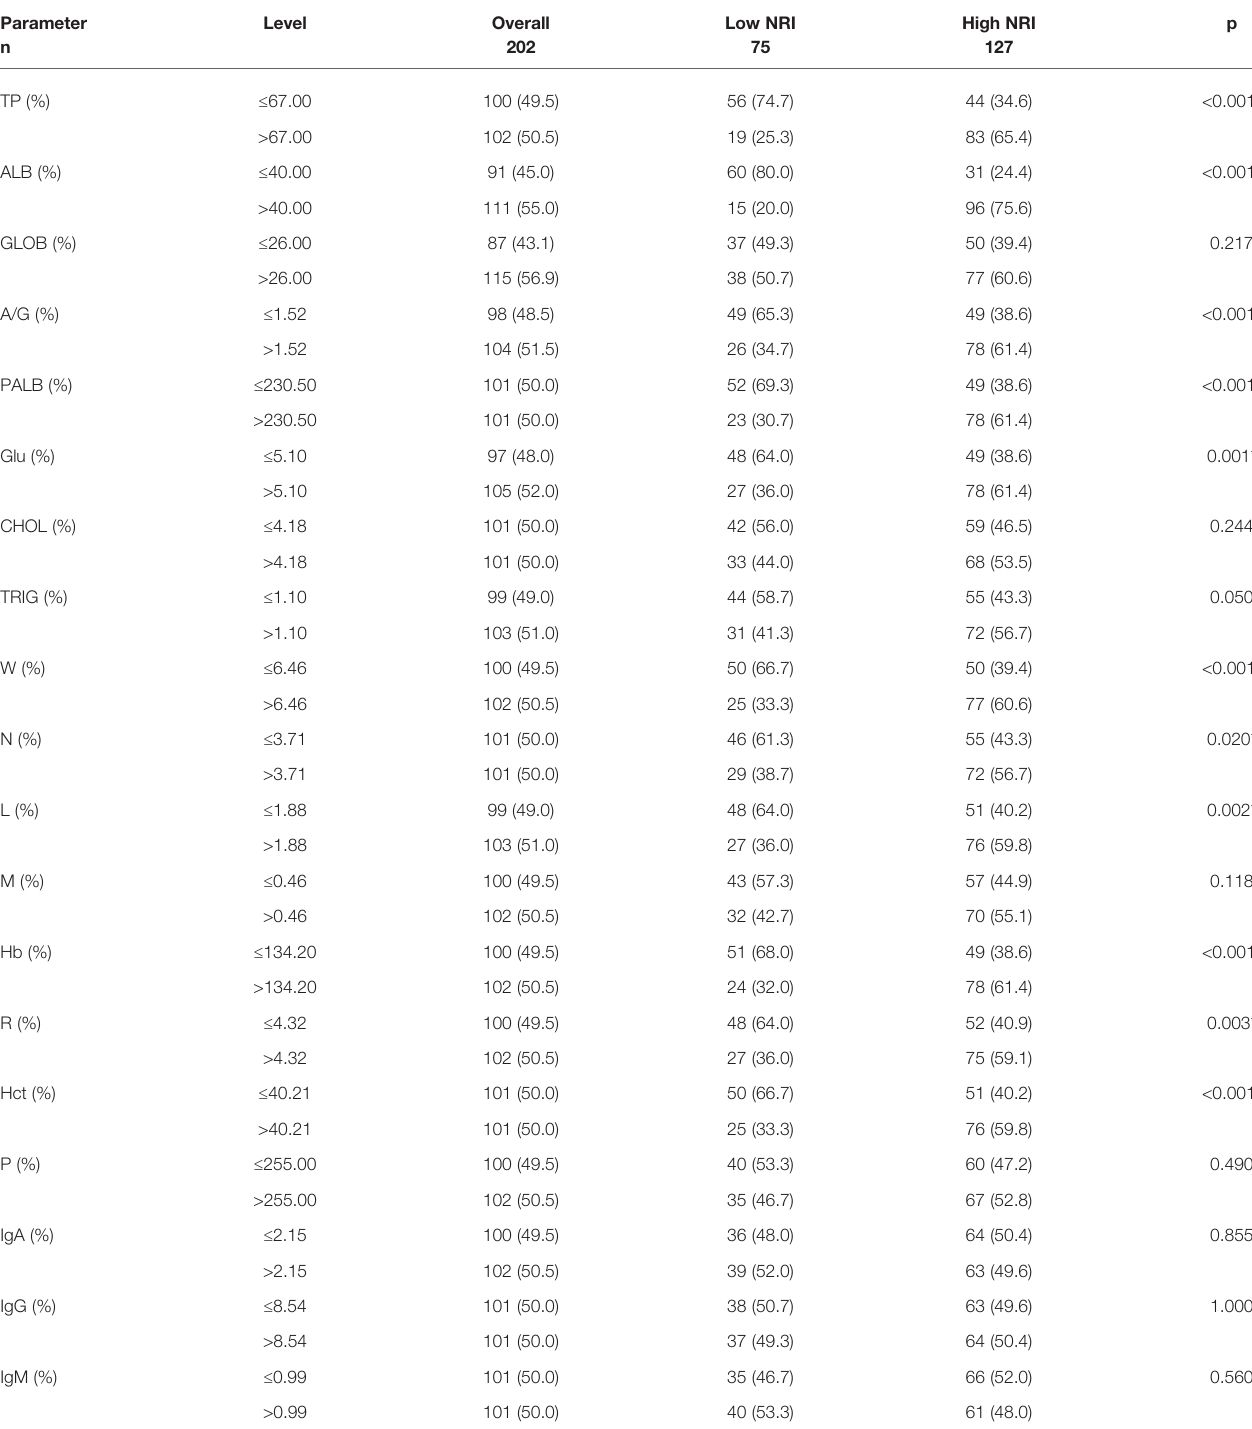
TABLE 2 | The relationships of NRI with nutritional and blood parameters.